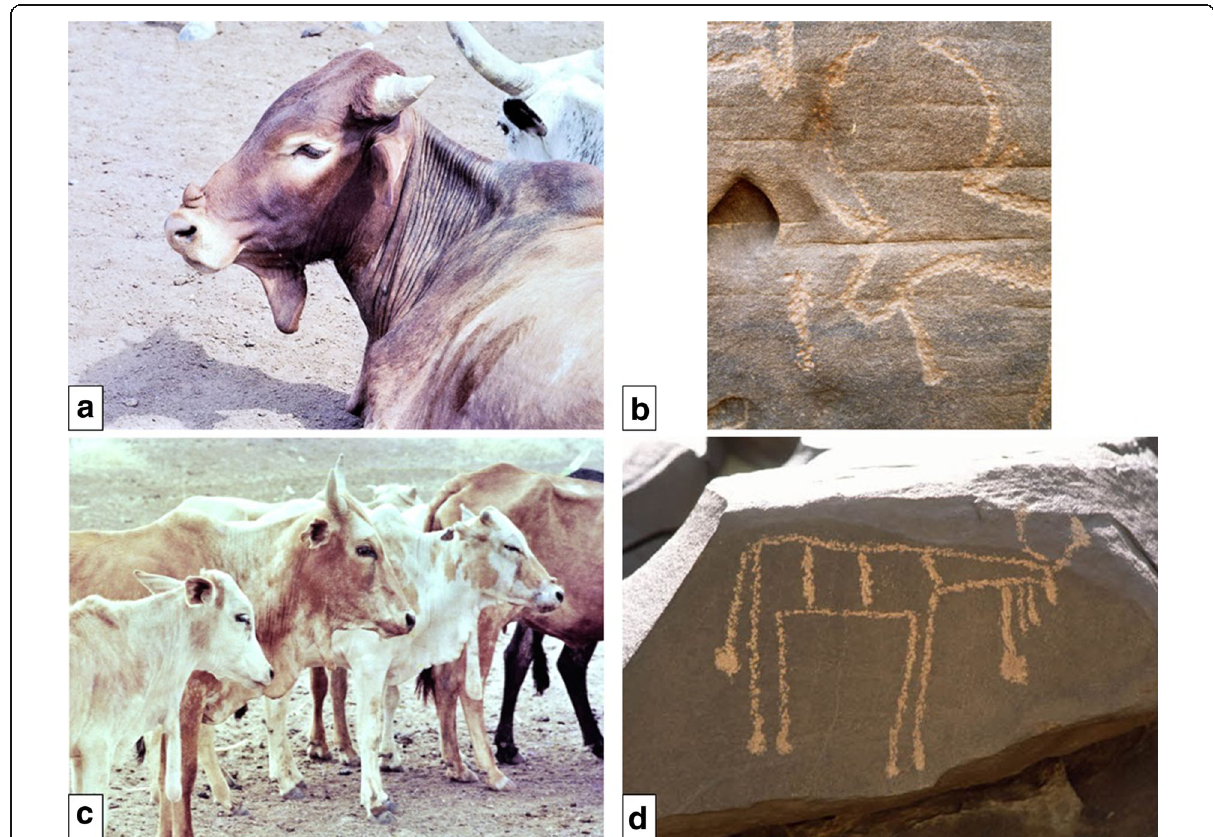
Fig. 8 a Head of a favourite-ox showing a flap of hanging skin in the chin area. b Detail of rock art depicting an ox with a similar hanging skin modification, Aïr Mountains, Niger, approx 3000 BC. (David Coulson, Trust for African Rock Art). c Three cattle showing dewlaps with hanging skin flaps of various length, Lokwnamoru. d Rock engraving showing a cow with similar hanging skin flaps from dewlap, Aïr Mountains, Niger, approx 3000 BC (David Coulson, Trust for African Rock